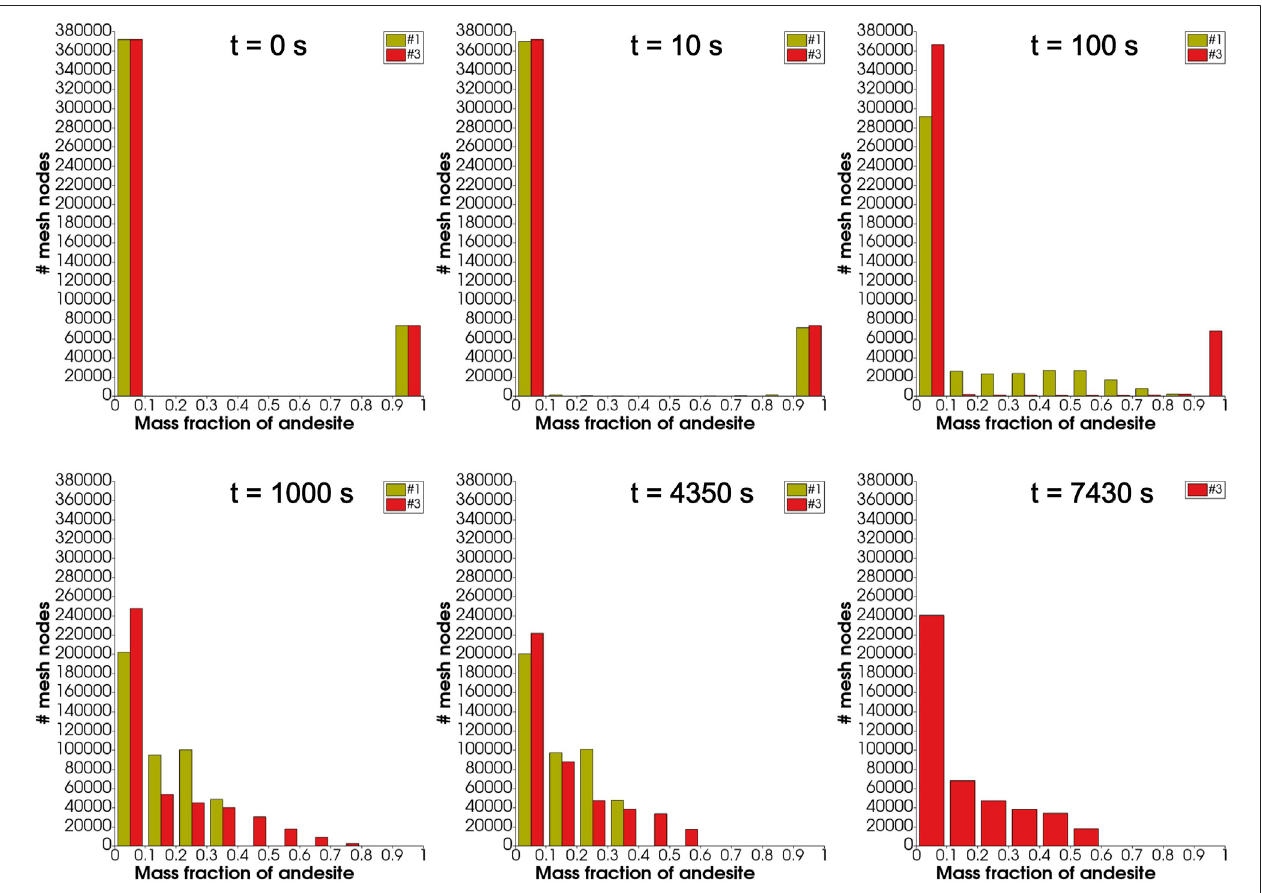
FIGURE 5 | Distribution of composition across mesh nodes. Simulation case 1 was run up to 4,350 s. Therefore, at 7,430 s, only #3 is displayed.